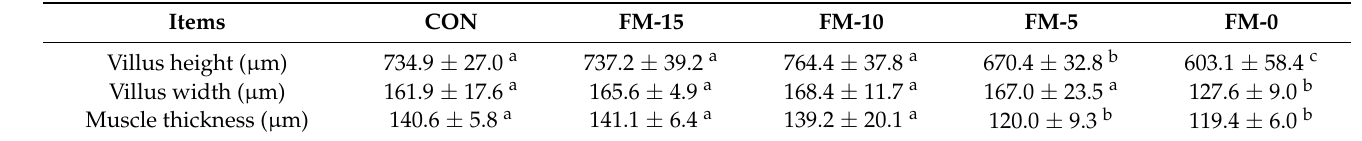
Table 7. Effect of replacing fishmeal with the CPC and CAP mixture on the foregut morphology of rainbow